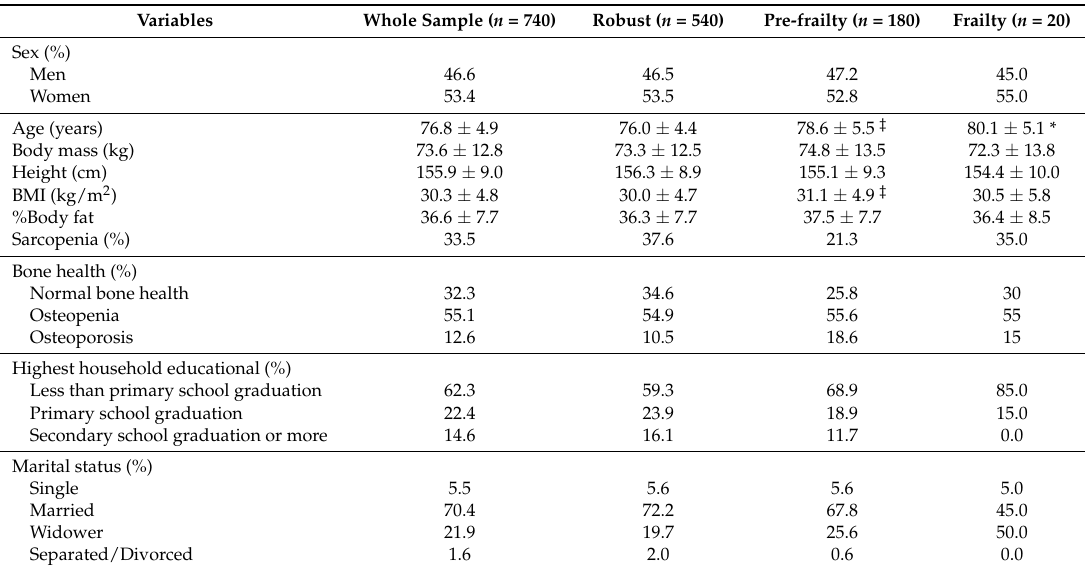
Table 1. Anthropometric and descriptive